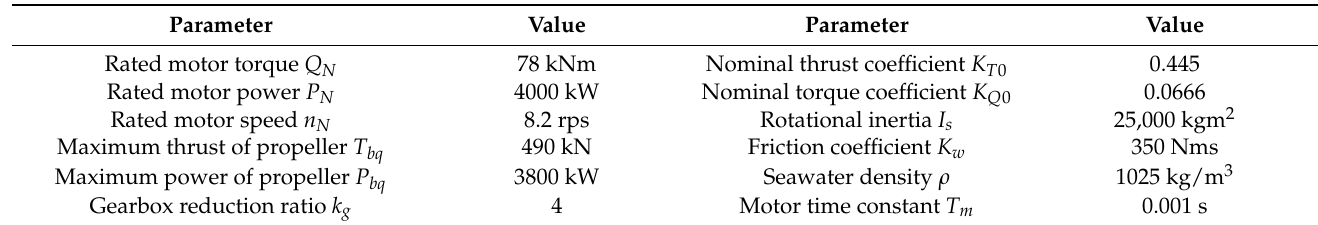
Table 3. Experimental parameters of the MEP system.